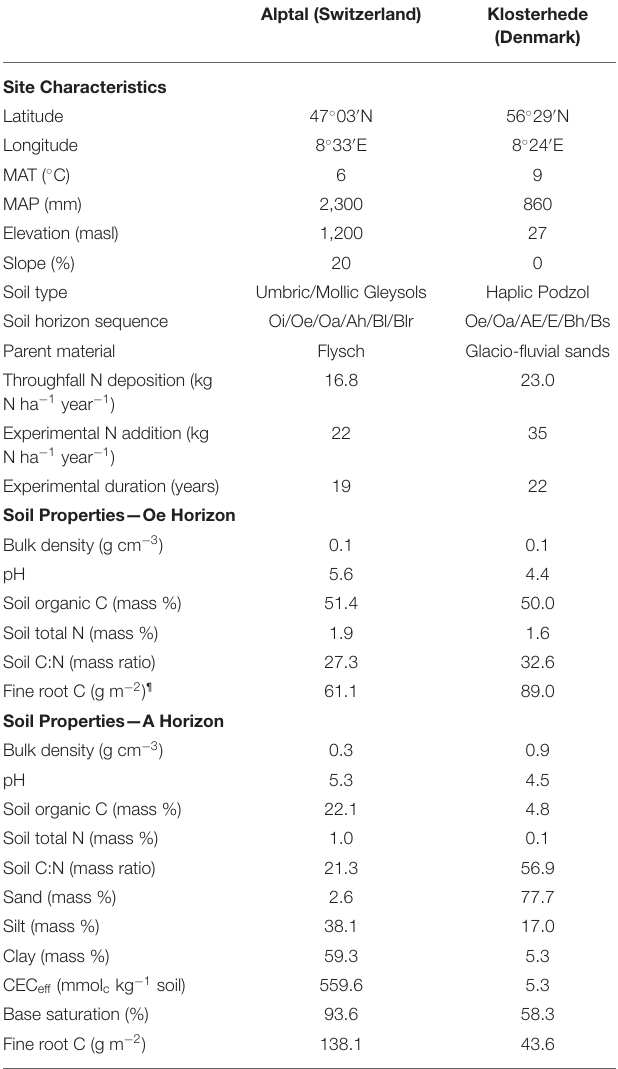
TABLE 1 | Site characteristics and soil properties of control plots at Alptal (Switzerland) and Klosterhede (Denmark). Alptal